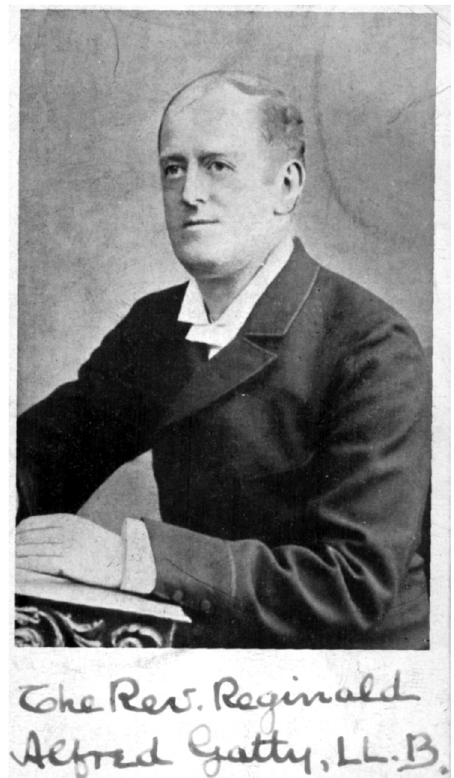
Figure 2: Portrait of the Rev. Reginald Alfred Gatty, LL.B; date unknown. Image reproduced by kind permission of She ffi eld Libraries and Archives and Picture She ffi